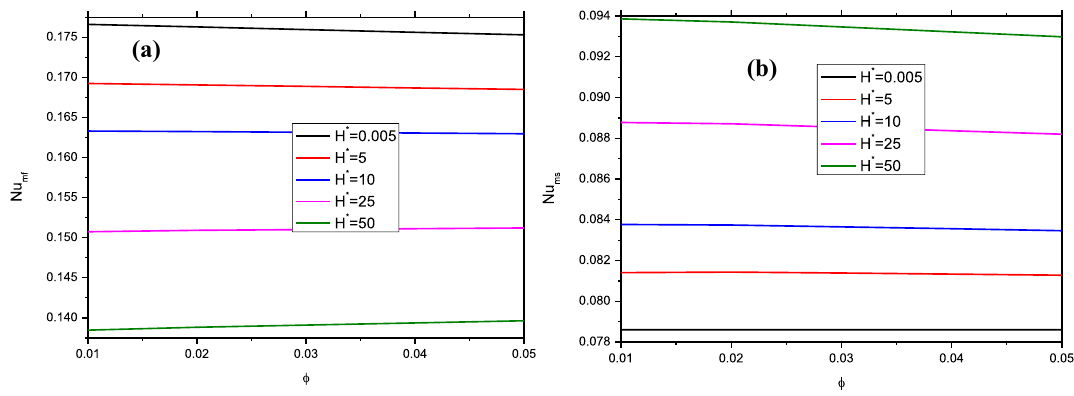
Fig. 12 Internal heat transfer parameter profiles of the average Nusselt number of fluid phase (left) and solid phase (right) for TiO nanofluid at Ha = 10 , Q = 1 , Da = 10 – 3 , Ri = 1 , Gr